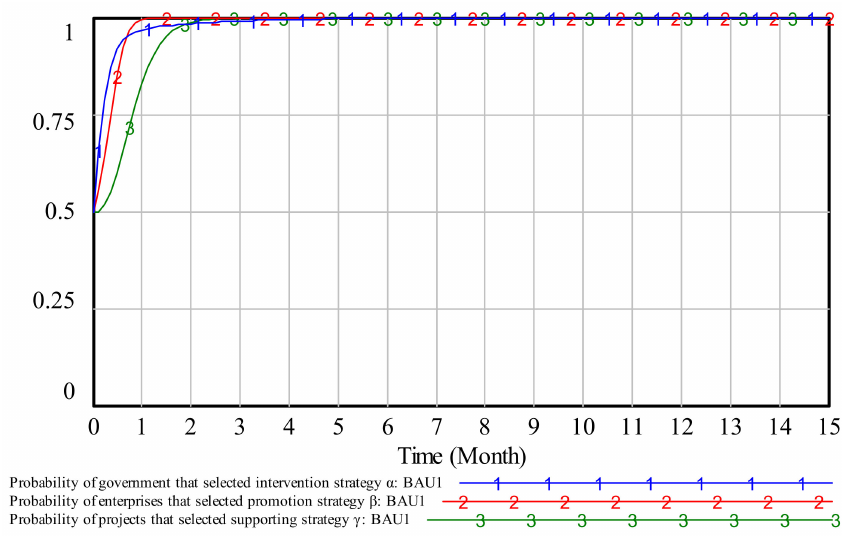
Figure 3. Stability test of the equilibrium point (1,1,1).